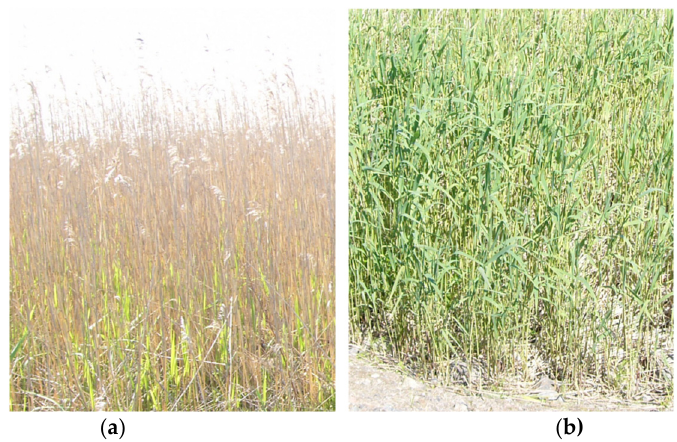
Figure 2. Old reed bed of target 2 ( a ) and new reed bed of target 3 ( b ). The photographs are taken on